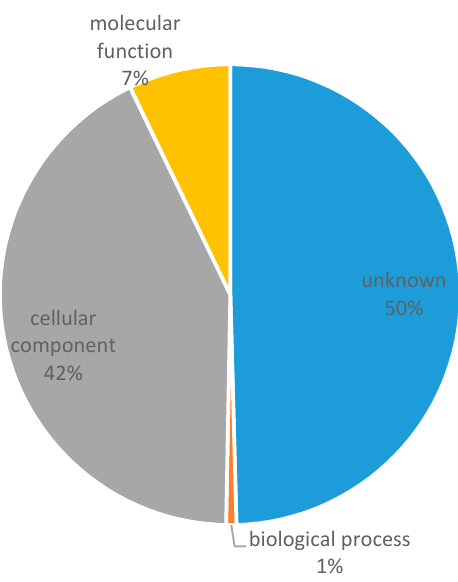
Figure 1. Distribution of first level gene ontology classification of the de novo assembly.